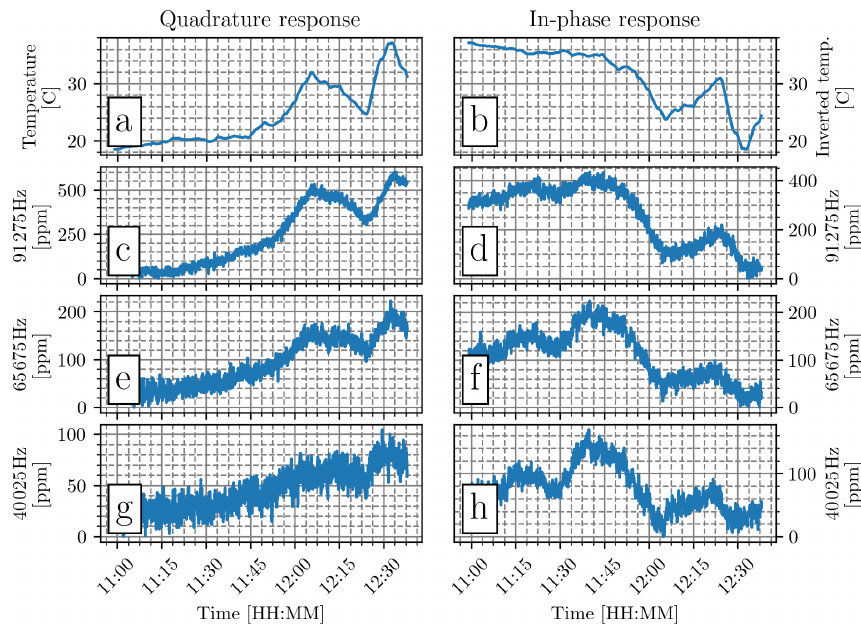
Figure 4. Results of Test 2: a static CSEM versus temperature measurement conducted in a quiet electromagnetic environment. The data are levelled to zero and processed with a median filter. Panels (a) and (b) are the measured temperatures, but (b) is multiplied by − 1 to invert the temperature for better comparison with parts-per-million observations for different frequencies in (c) to (h)